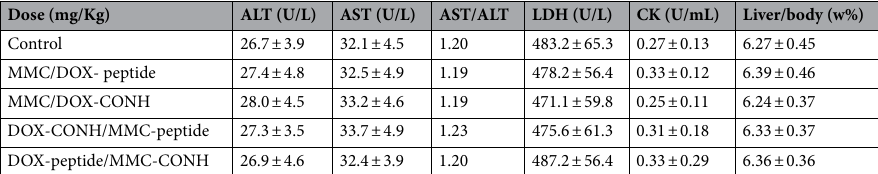
Table 3. Serum biochemical parameters and relative liver weight at 2-week after administration of different doses of the conjugates to mice.